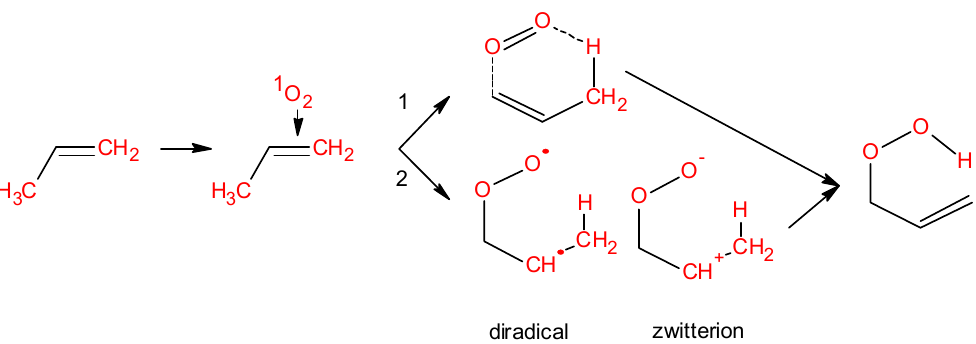
Figure 4. Formation of lipid ROOH via ene reaction. Ene reaction occurs through two different ways: Concerted pathway (reaction 1) and stepwise mechanism (reaction 2). During the stepwise mechanism 2, different intermediates are formed: Diradical and zwitterion.